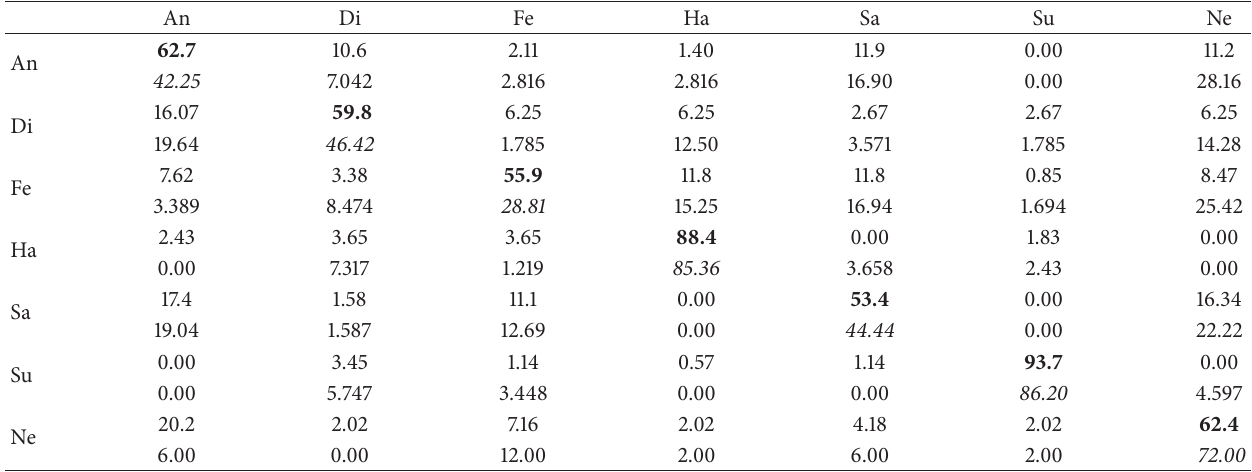
Table 4: The confusion matrix obtained by applying our approach on BU-4DFE database. The first row in each expression represents results using SVM classifier. The other row shows the results using KNN